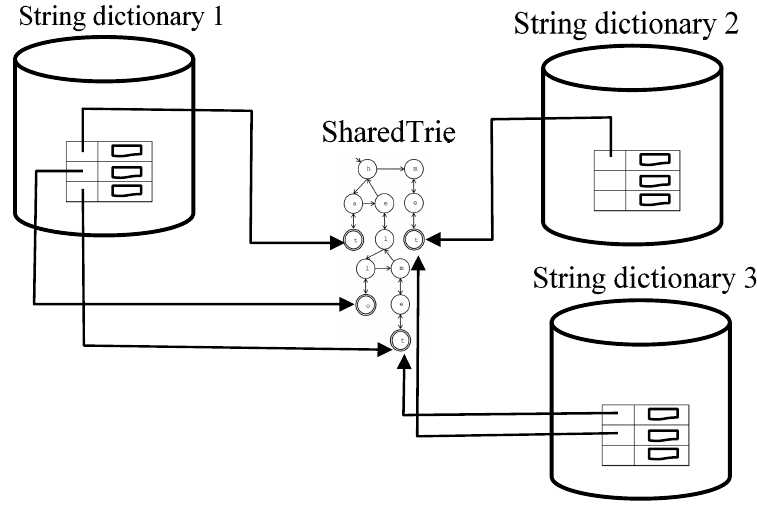
Figure 2. The proposed architecture.